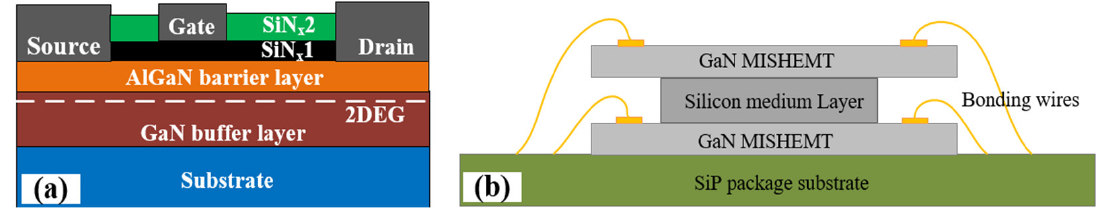
Figure 1. ( a ) Schematic device structure of GaN MISHEMT, ( b ) double-layer GaN MISHEMT.